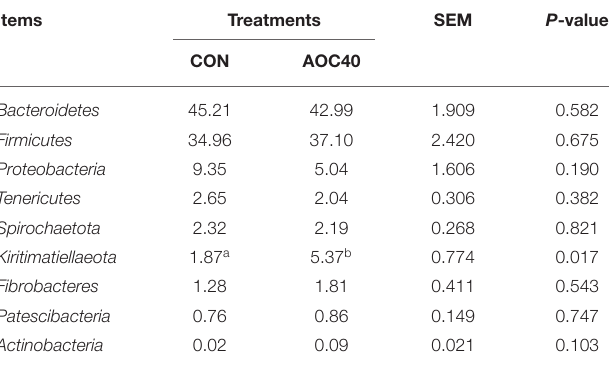
TABLE 6 | Effects of Aspergillus oryzae culture supplementation on the phylum-level average relative abundance (% of total reads) of rumen microbial community of Hu sheep.